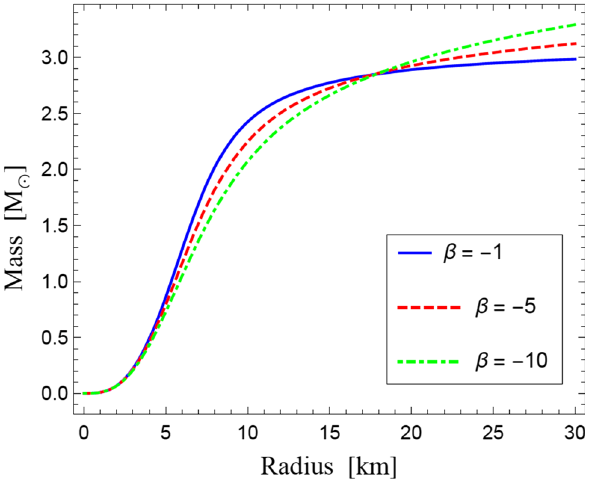
Fig. 1 Mass profile graph of a neutron star where α = − 1 and three different variations of β . The value of (cid:19) = 4 / 3, (cid:17) = 2 [27] and ϕ = 2 . 036 × 10 − 35 [32]